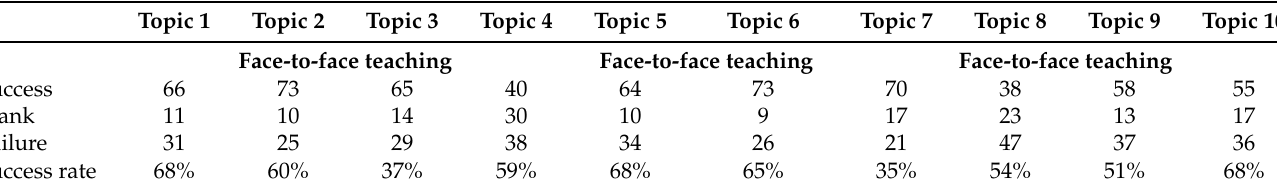
Table 13. Final test results by topics Year 2020–2021.